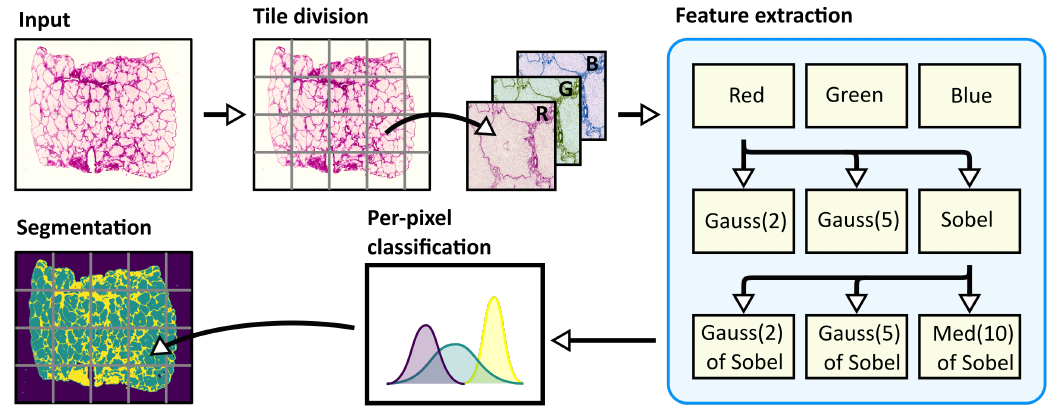
Figure 2. Handcrafted Texture Feature Segmentation algorithm. Input H&E stained image is divided into tiles. Each tile is processed separately. Red (R), Green (G), and Blue (B) image channels are used as first features. The Sobel filter and the Gaussian smoothing with the standard deviation of 2 pixels and 5 pixels (Gauss(2)) and Gauss(5)) are applied to the Red channel. The output of the Sobel filter is